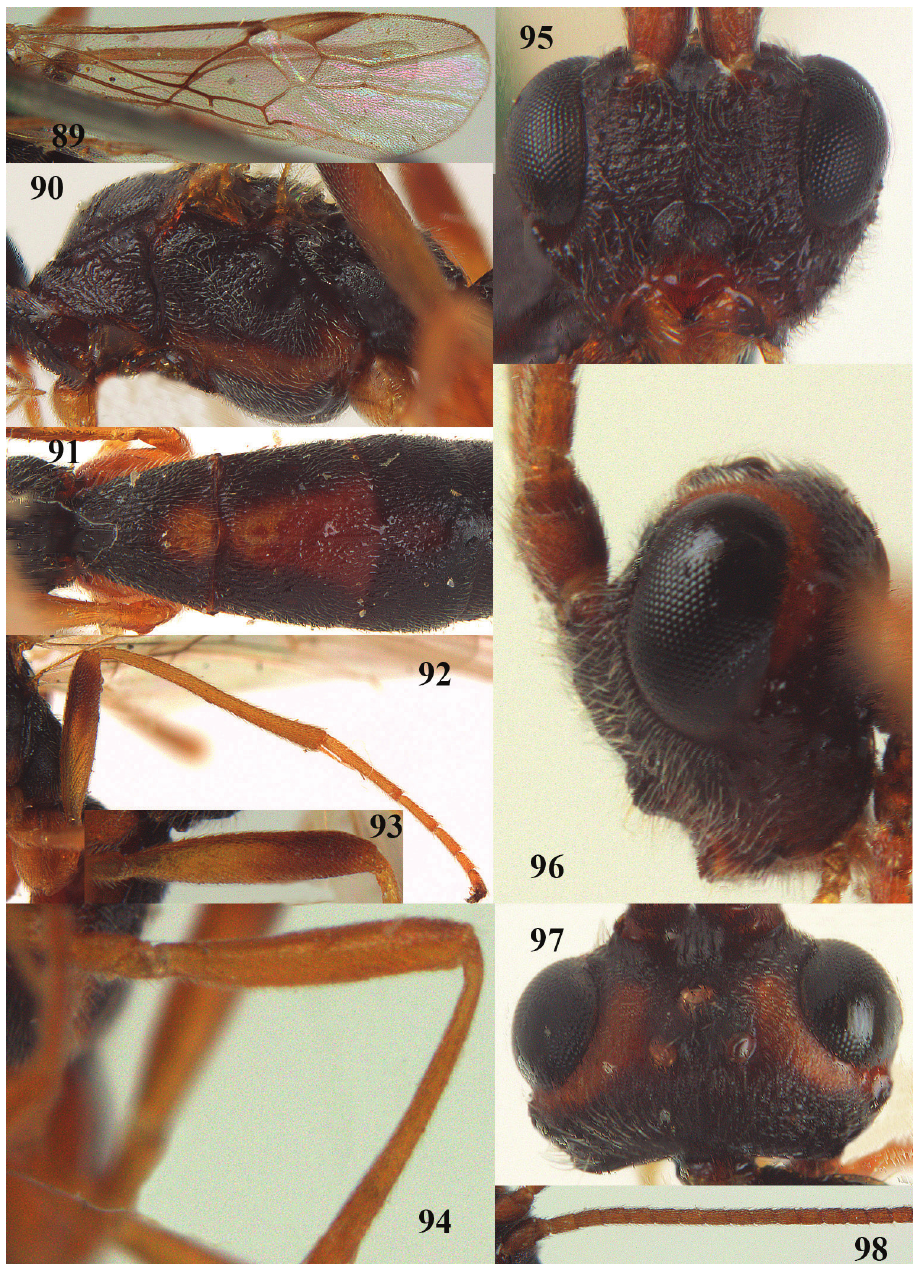
lateral 97 head dorsal 98 basal segments of